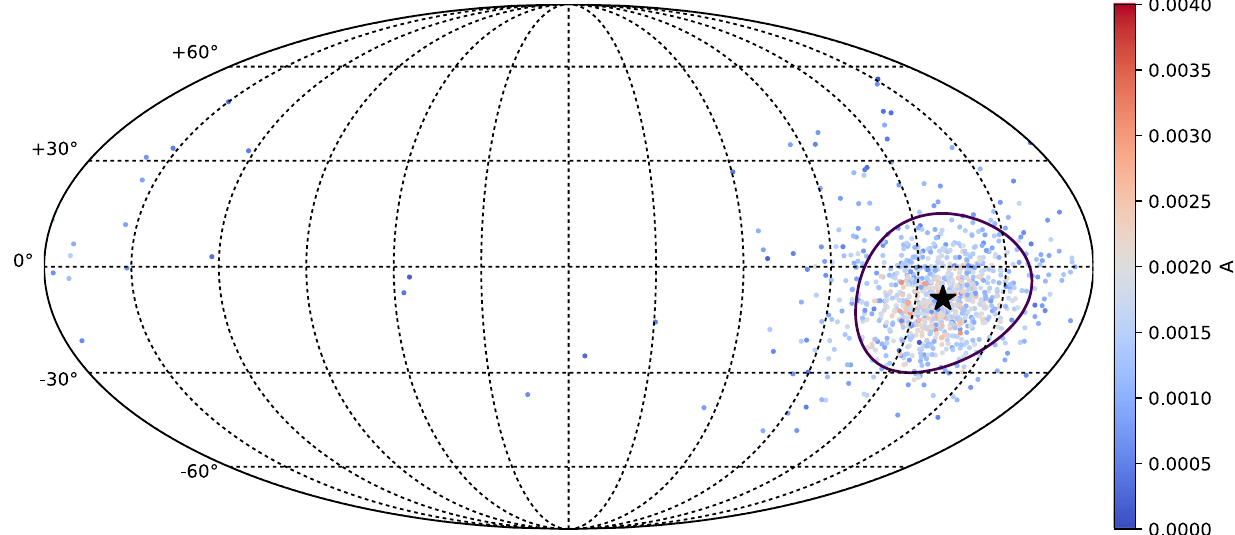
Fig. 2 Best-fitting dipole direction (star) and 1 σ error range of the Union2.1 data set. Scatter points represent dipole fitting results of simulating samples